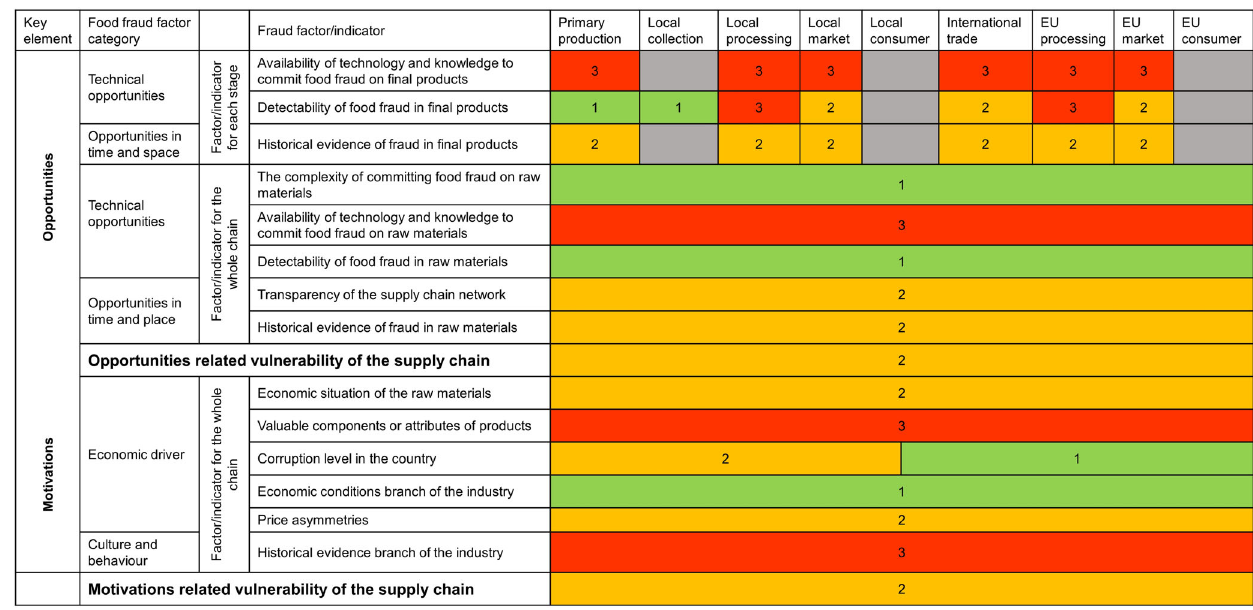
Fig. 2 Visualization of the opportunities and motivations related vulnerability in ginger supply chain from China to the European Union (EU). Note: Number 1, 2 and 3 re fl ected a low, medium, and high vulnerability